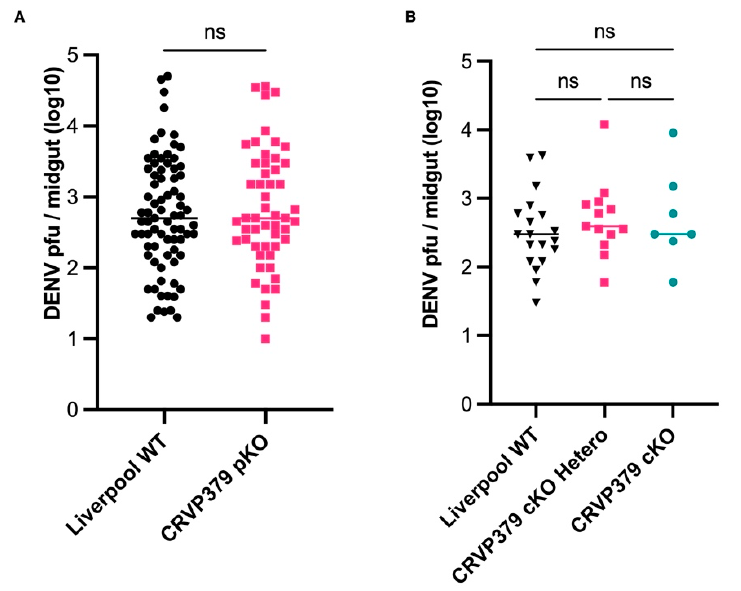
Figure 8. DENV titers in Ae. aegypti midguts at 7 days after infection, as determined by plaque assay. ( A ) CRVP-pKO compared with wild-type Liverpool mosquitoes. ( B ) CRVP-cKO heterozygous and homozygous mosquitoes compared with wild-type Liverpool mosquitoes. (Dunn’s multiple comparisons test, ns = not statistically significant).